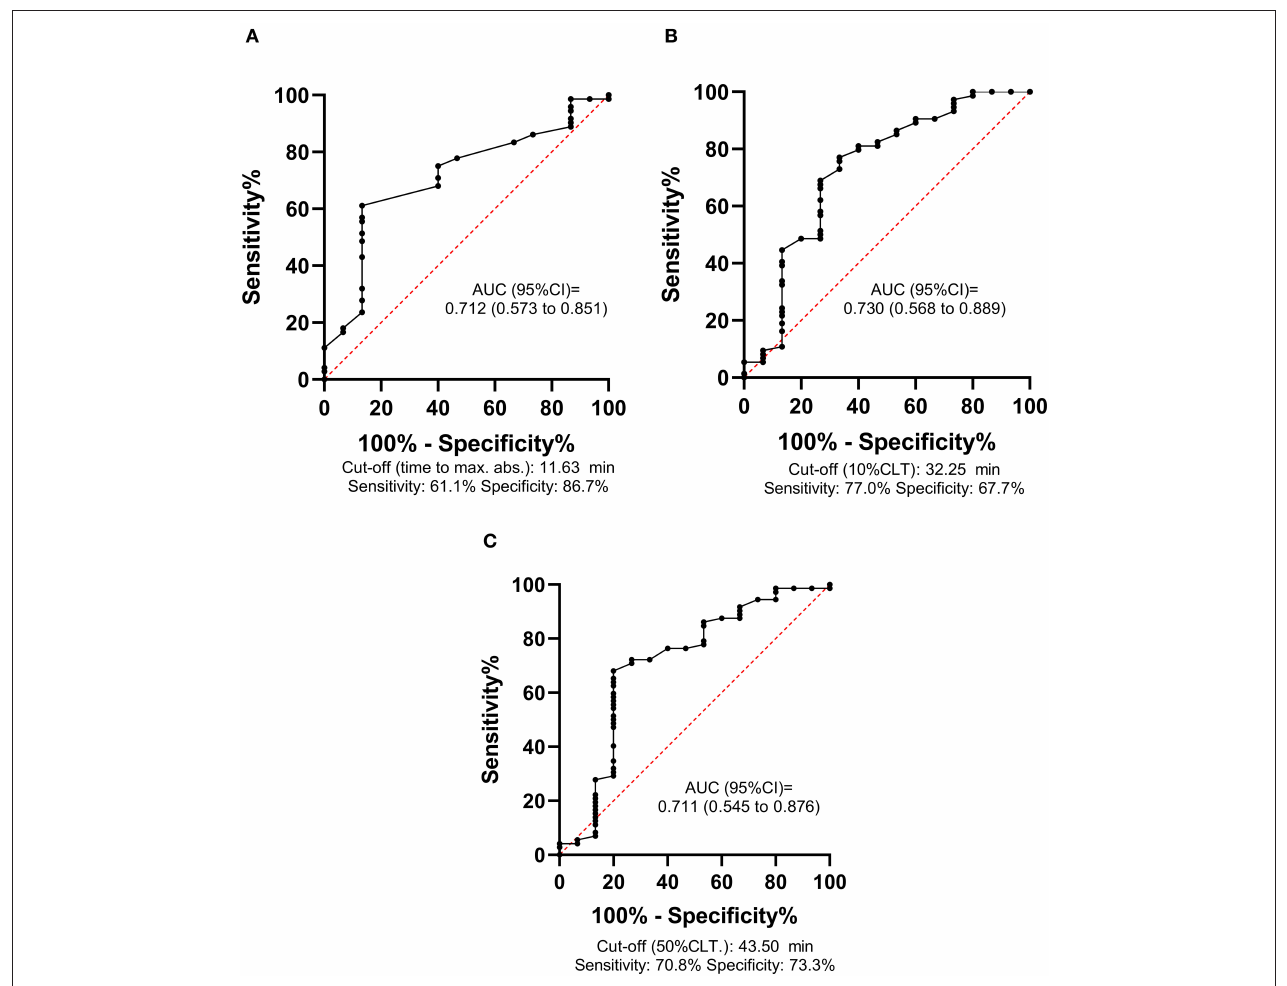
FIGURE 4 | Receiver operator characteristic (ROC) curves of the modified clot lysis assay (mCLA) parameters for predicting long-term functional outcomes (mRS 0–1 vs. 2–6) of intracerebral hemorrhage stroke patients. mCLA is performed in the presence of cell-free DNA and histones. ROC curve and descriptive statistics including best cut-off value as determined by the Youden index are depicted for time to maximal absorbance parameter (A) , 10% clot lysis time (10%CLT) (B) , 50% clot lysis time (50%CLT) (C)